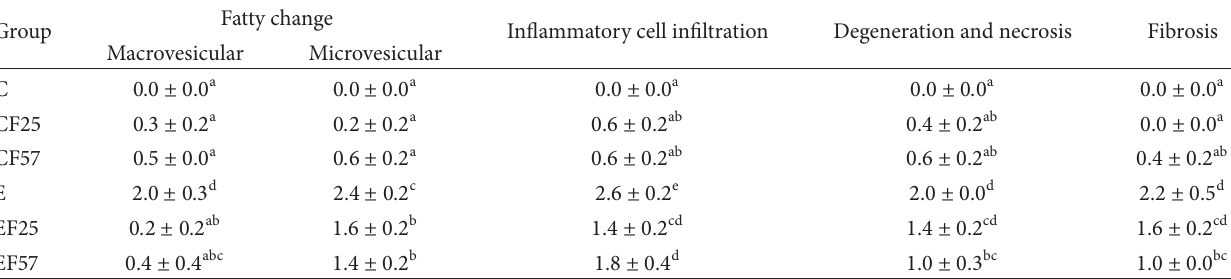
Table 5: Effects of fish oil on histopathological analysis of liver tissue in rats under chronic ethanol feeding 1,2 . Fatty change Group Inflammatory cell infiltration Degeneration and necrosis Fibrosis Macrovesicular Microvesicular